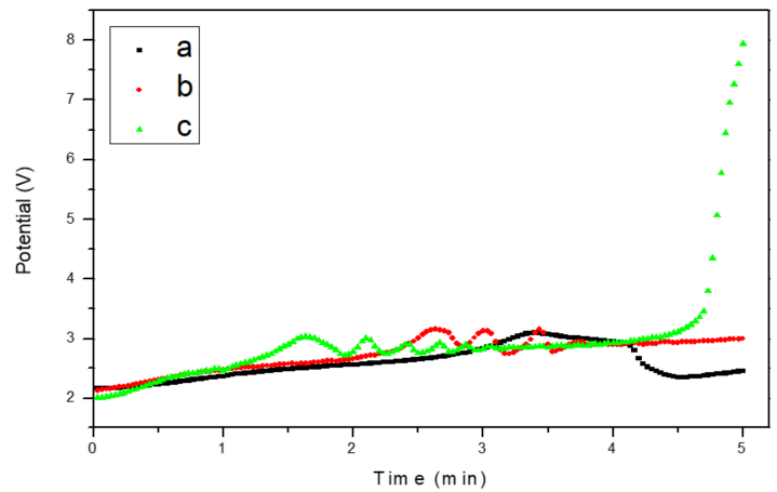
Figure 3. Chronophotenciometry of EC of CaOx performed on ITO substrate modified with chitosan–ESM fibers. ( a ) Control (bare substrate), ( b ) R-chitosan fibers, ( c ) A-chitosan fibers.